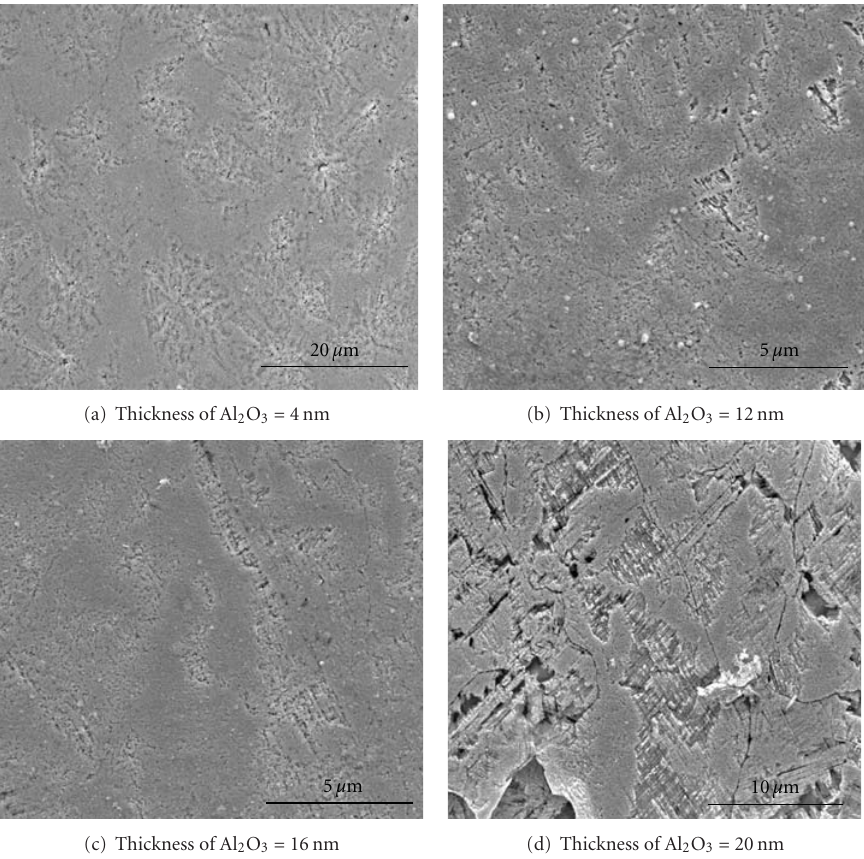
Figure 9: SEM images of pc-Si films for samples with various Al oxide layer thicknesses.